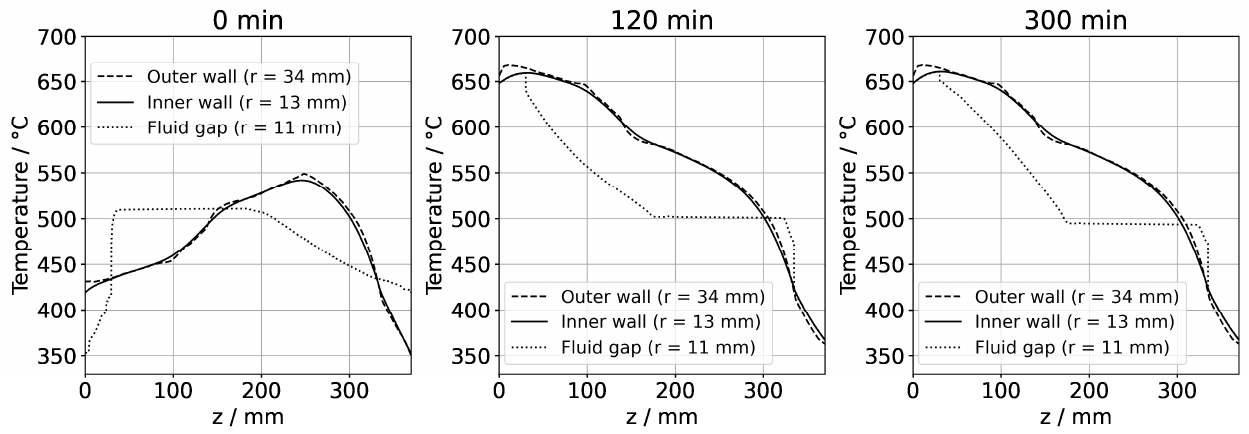
Figure 14. Temperatures inside the autoclave wall near the outer (dashed lines) and inner (solid lines) walls and inside the fluid near the inner autoclave wall (dotted lines). The data labeled with 0 min correspond to quasi-stable conditions at dissolution stage, whereas the data labeled with 120 min correspond to the time at which growth stage set temperatures were reached. The data labeled with 300 min correspond to quasi-stable conditions at growth